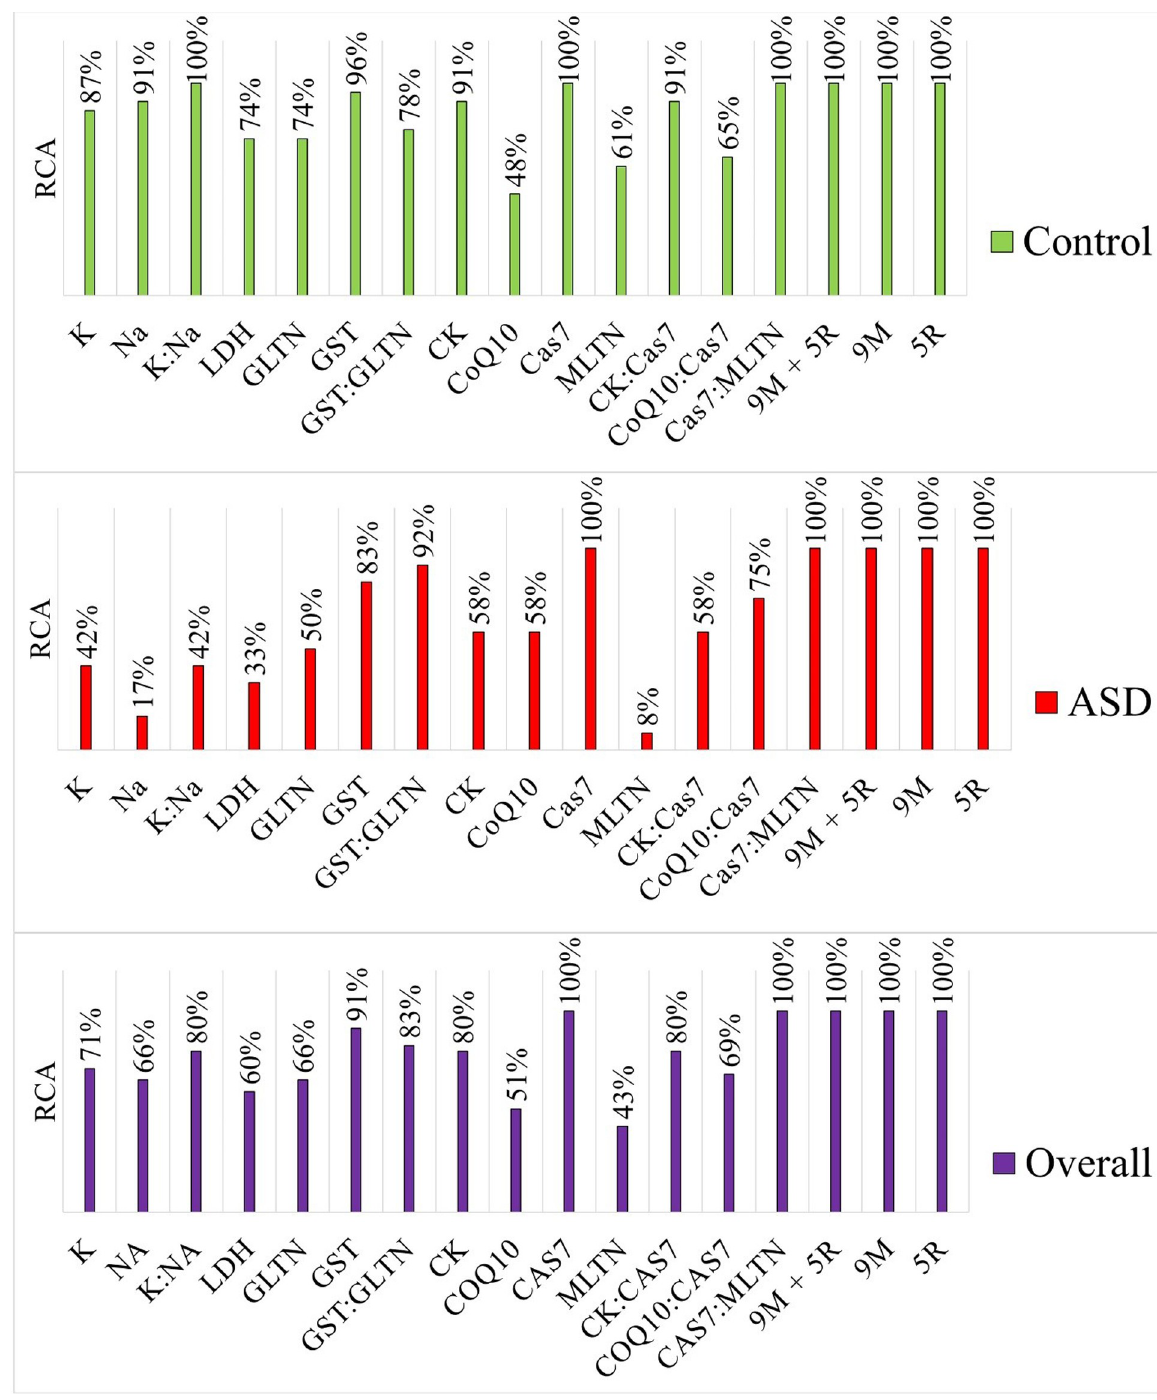
Fig 6. Estimating the predictive power of variables using library-based assignment. A library containing 12–13 � autistic and 23–24 � healthy participants was used for identification. K: potassium, Na: sodium, LDH: lactate dehydrogenase, GLTN: glutathione, GST: glutathione S- transferase, CK: creatine kinase, CoQ10: co-enzyme Q10, Cas7: caspase 7, MLTN: melatonin, RCA: rate of correct assignment, and ASD: autism spectrum disorder. � To identify any given participant, the participant was removed from the library and then submitted as unknown. Accordingly, autistic participants were identified against a library of 12 autistic and 24 control participants, while control participants were identified using a library of 13 autistic and 23 healthy participants.